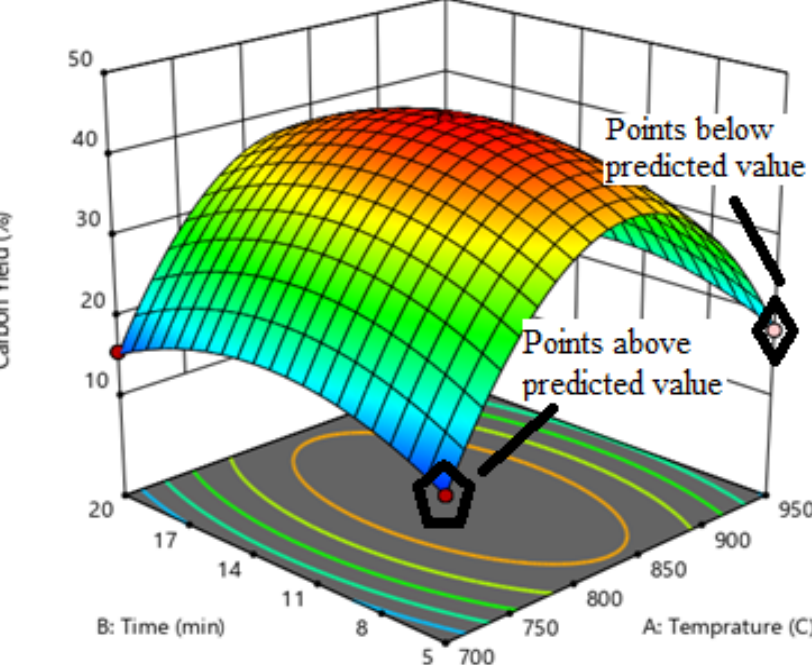
Figure 5. Effects of variables on carbon yield.